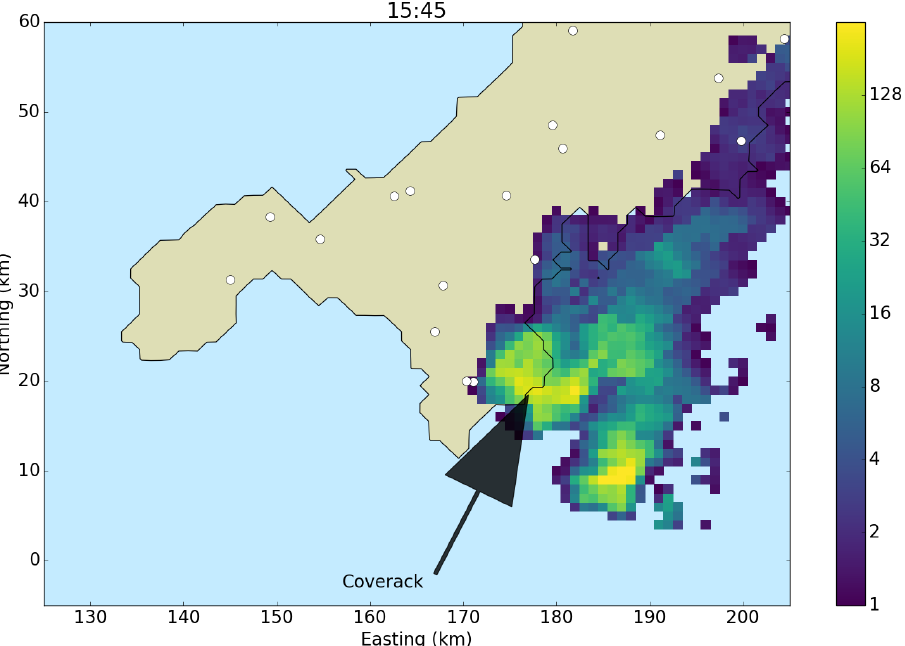
Figure 2. Radar-derived rainfall over the South-West peninsular of the UK, at 1545 UTC on 18 July 2017. The circles indicate the position of rain gauges, the colour scale refers to the radar-derived instantaneous rainfall rates in mm h − 1